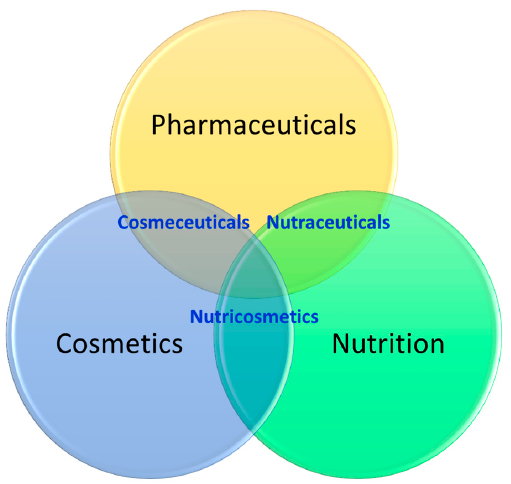
Figure 1. Major applications of mushroom in pharmaceutical, cosmetics, and nutrition, and their interactions.